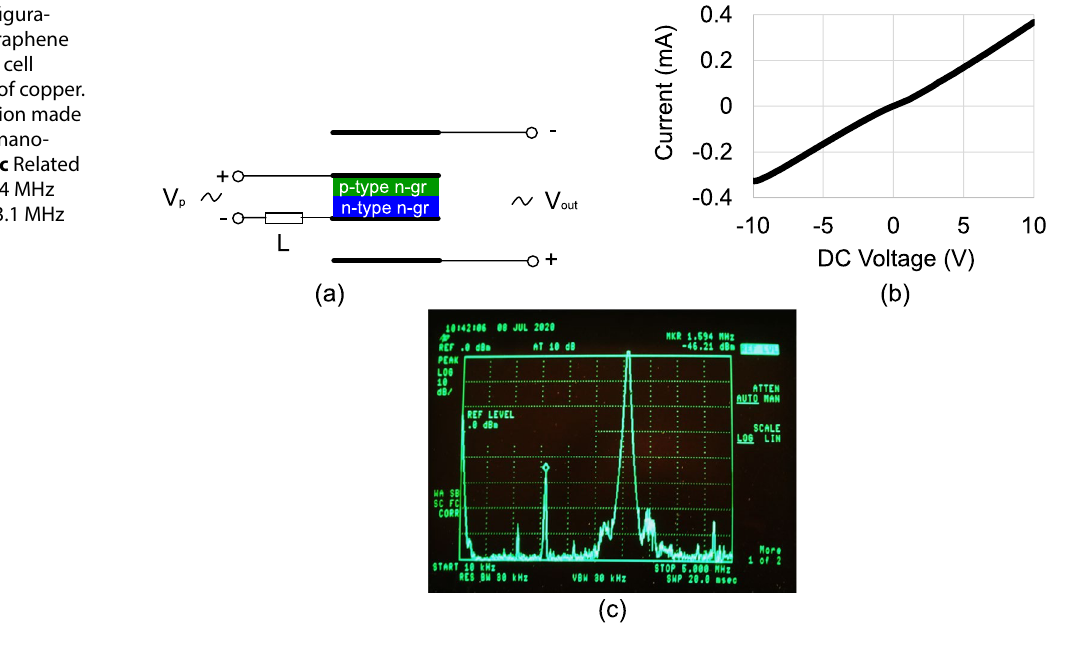
Fig. 10 a Circuit configura- tion with the nano-graphene (n-gr) gate. The outer cell electrodes are made of copper. b I–V curve of a junction made of chemically doped nano- graphenen-gr flakes. c Related oscillations at f = 1.594 MHz when pumped at f = 3.1